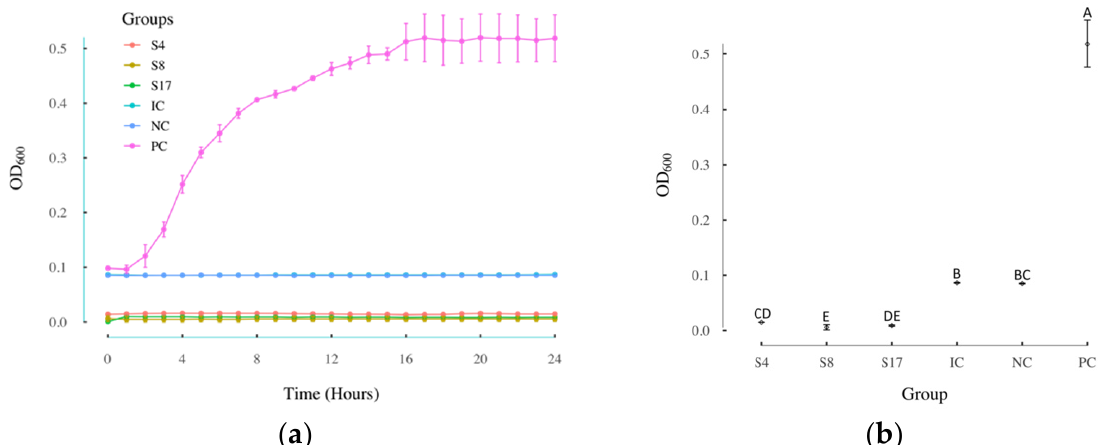
Figure 4. Compounds effective in growth inhibition assay using E. coli . (a) The growth curves of E. coli over 24 h under different treatment conditions; (b) the OD 600 values of E. coli at 24 h under different treatment conditions. ANOVA revealed significant differences among the different groups (F 5,12 = 385.3, p = 8.19 × 10 − 13 ). The results of the Kruskal–Wallis test are represented with letters (different capital letters = significantly different groups); PC: positive control groups; NC: negative control groups; IC: the known inhibitor fosfomycin 0.5 mg/mL groups; S4: albendazole 0.5 mg/mL groups; S8: diflunisal 0.5 mg/mL groups; S17: 2-amino-5-bromobenzimidazole 0.5 mg/mL groups; OD 600 : the absorbance at 600nm; n = 3; error bars represent standard deviations.